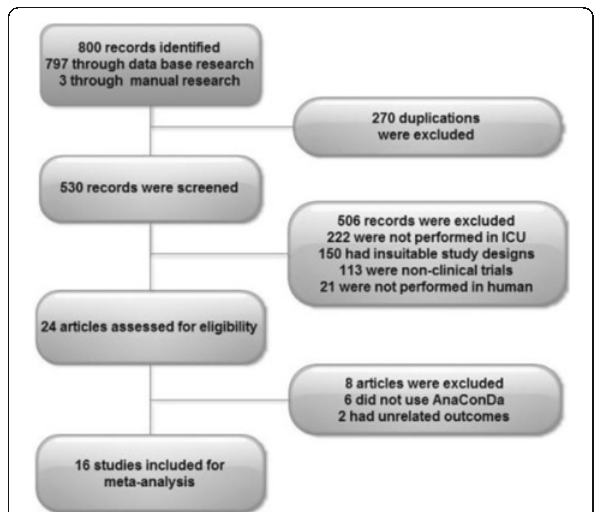
Fig. 63 (abstract A146). Flow chart for the study selection process